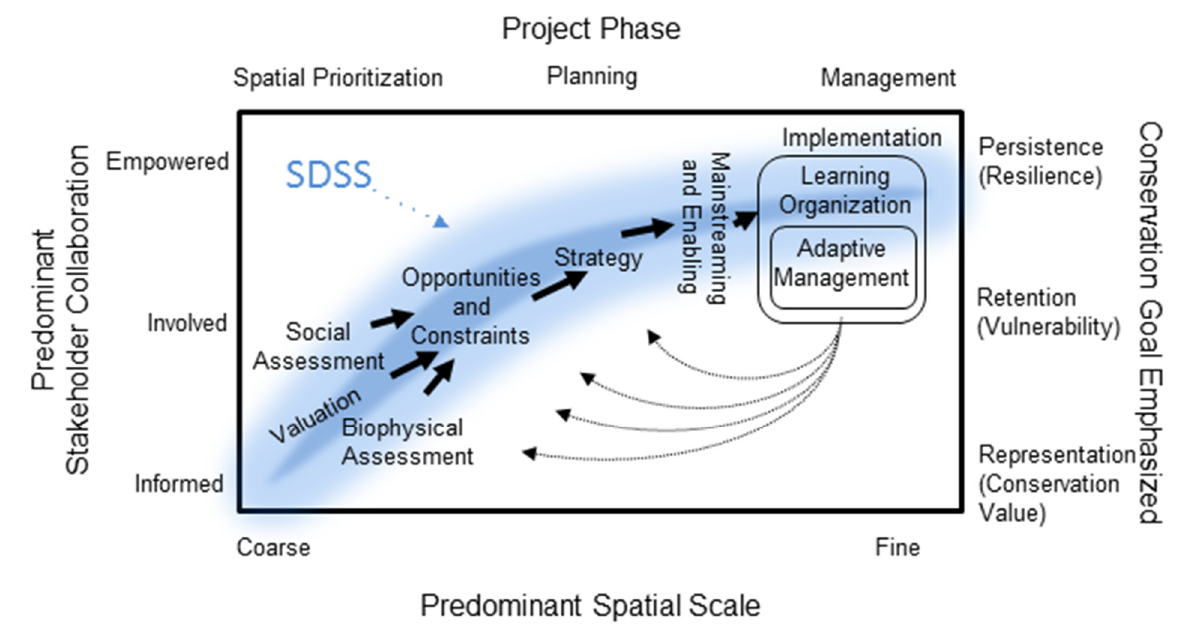
Figure 1. An operational model with an emphasis on engagement, being supported by an SDSS. A well designed SDSS can expand over time to support all phases of the conservation planning operational model. (Adapted from [6,15,21]).